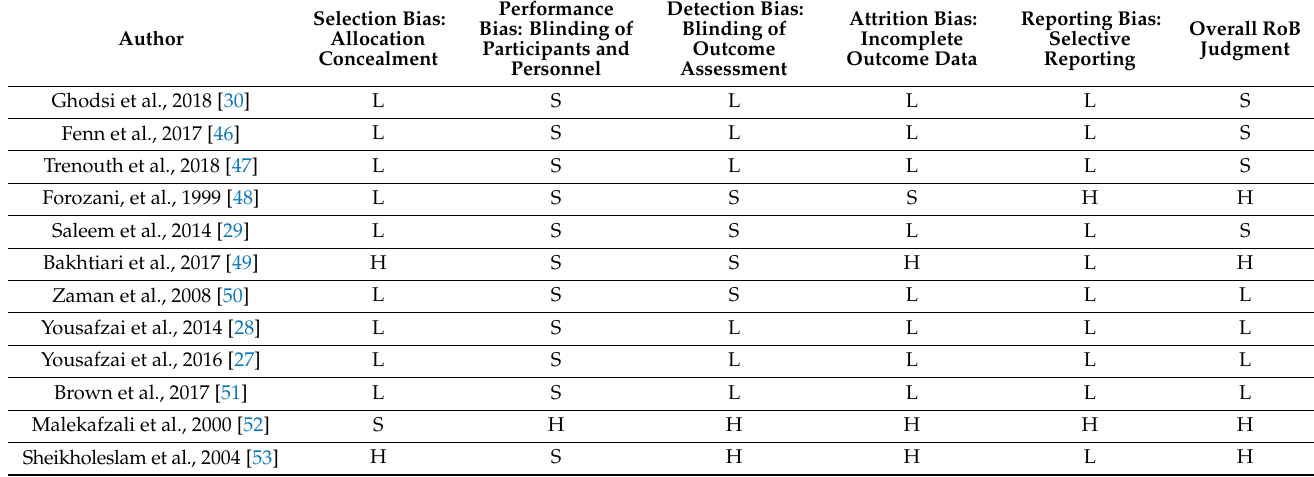
Table 2. Risk of bias assessment of cluster